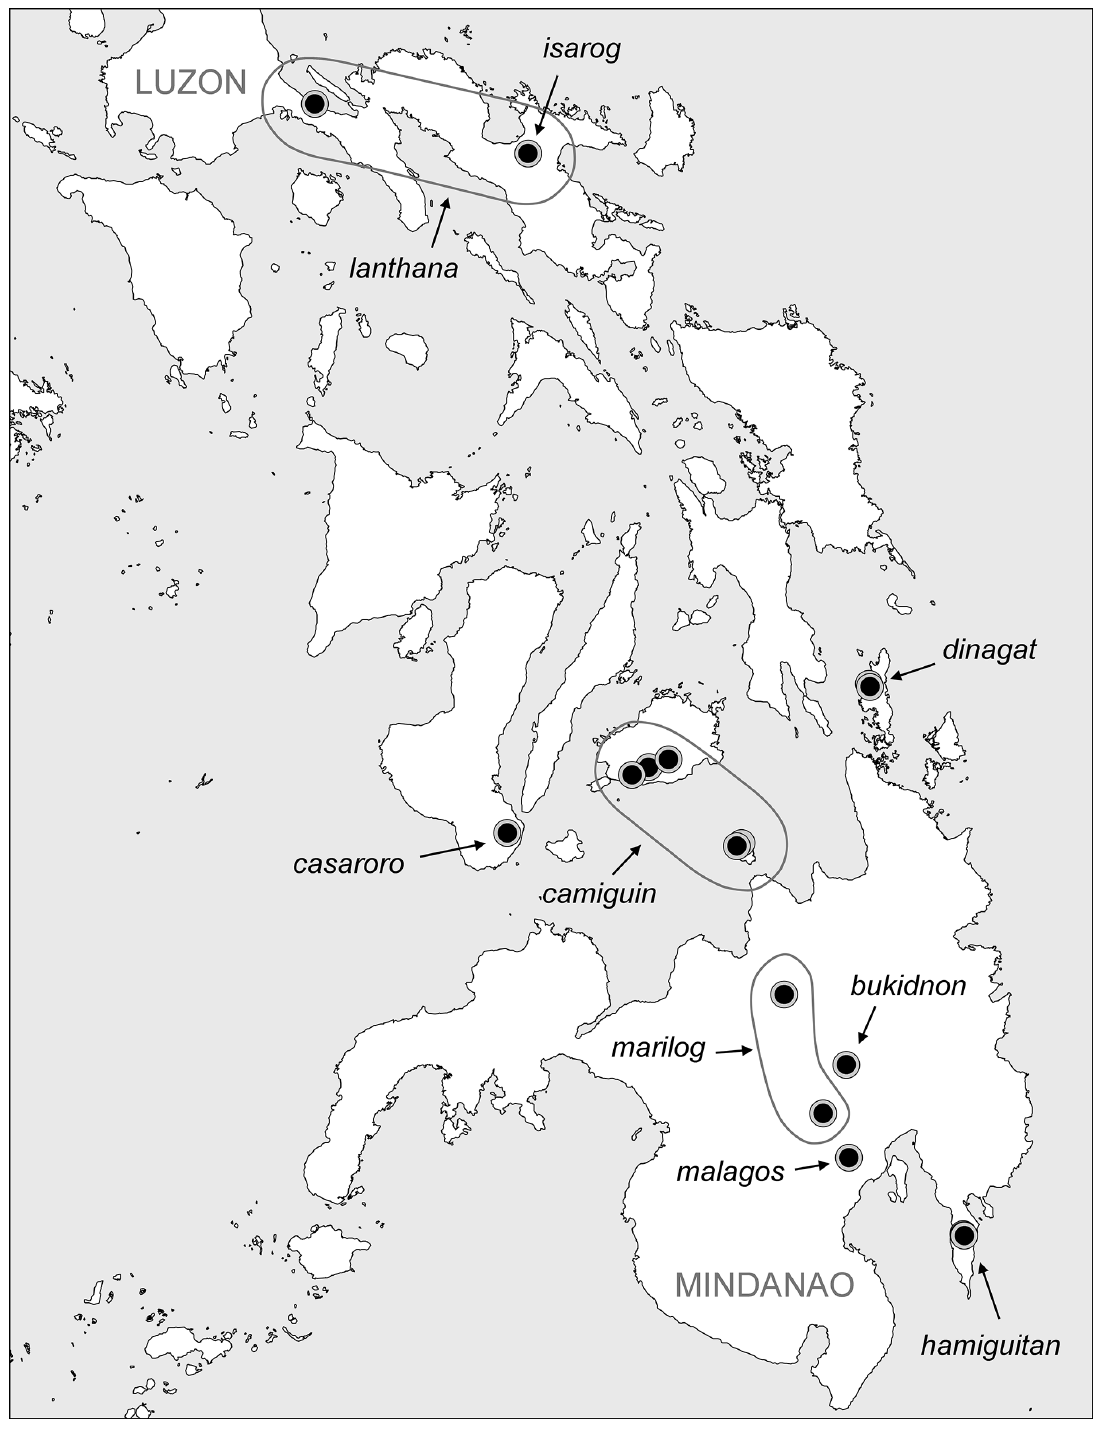
Fig. 16. Known distribution of the Panjange lanthana